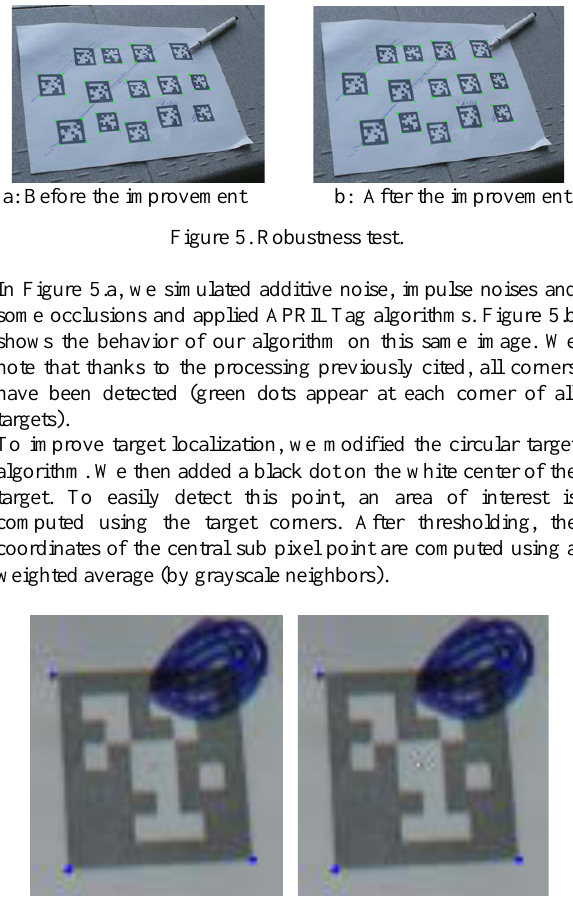
Figure 6. Target with central